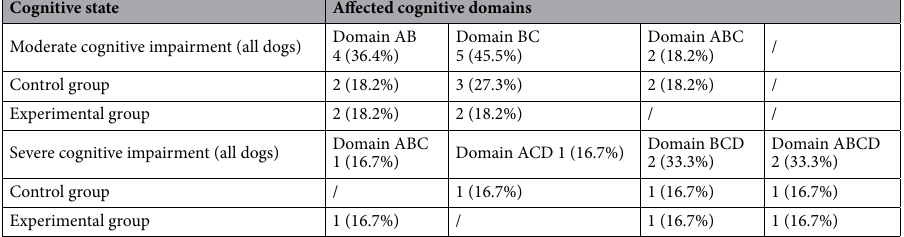
Table 1. Dogs’ cognitive status based on CADES score and their affected domains at the beginning of the